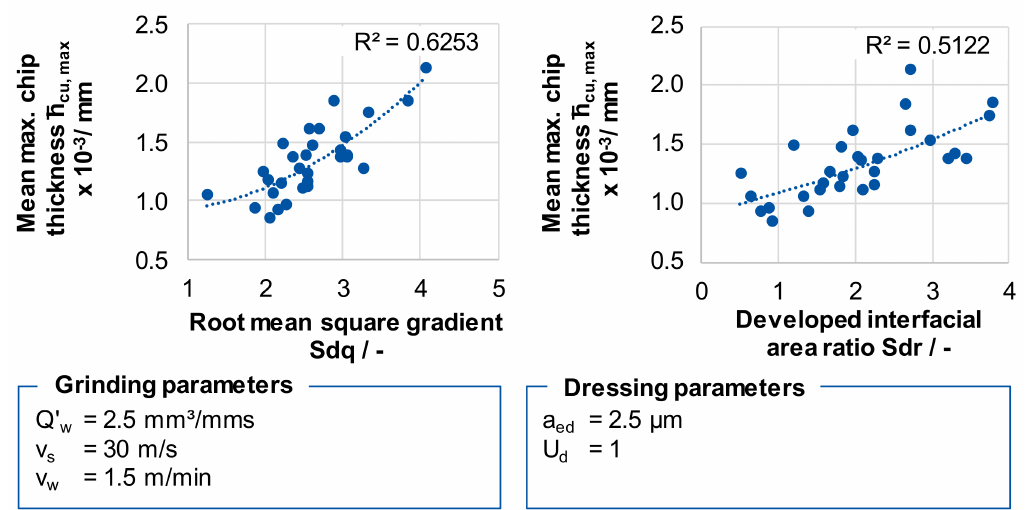
Figure 8. Correlation between the hybrid parameters and the mean max. chip